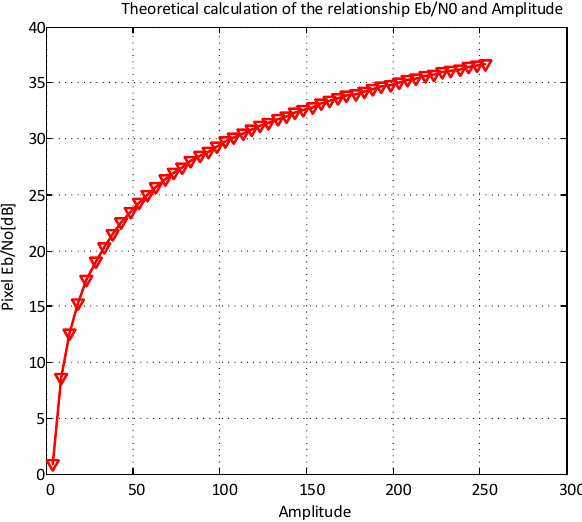
Figure 4. The theoretical relationship between Pixel Eb/No and image